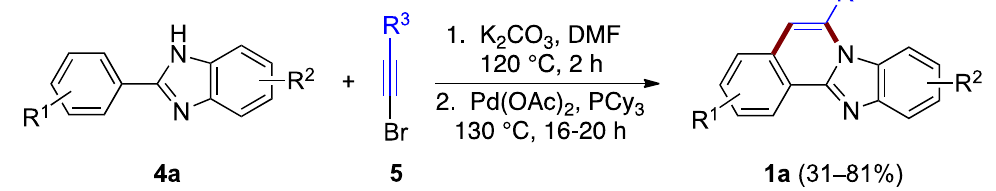
Figure 4. Hydroamination of bromoacetylene 5 by benzimidazole 4a .